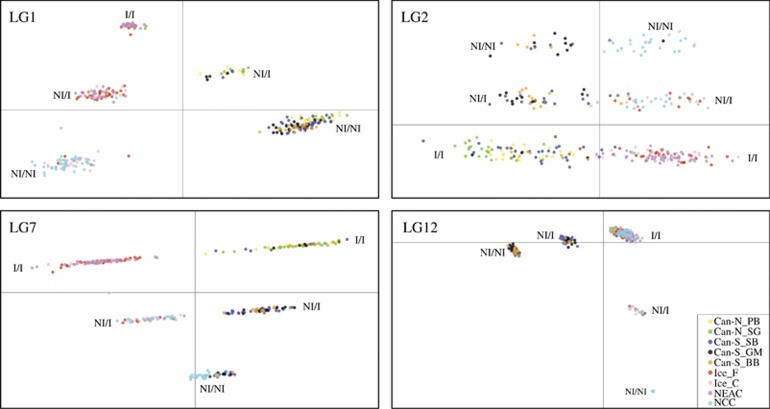
Discriminant analysis of principal components (DAPC) of the SNPs embedded within the inversions in LGs 1, 2, 7 and 12. Within all LGs a clear trimodal pattern, reflecting the inversion ‘genotypes’, is observed in addition to a broad trans-Atlantic division. Each dot represents an individual; NI/NI and I/I denote the homozygote noninverted and inverted clusters, respectively, whereas the NI/I denotes the heterozygote clusters. Inversion frequencies are listed in Supplementary Table S5. The analyses are based on n.pca=2 and n.da=2, calculated in ADEGENET. Can-N_PB, Placentia Bay; Can-N_SG, Southern Gulf of St Lawrence; Can-S_SB, Sambro; Can-S_GM, Gulf of Maine; Can-S_BB, Browns Bank; Ice_F, Iceland Frontal; Ice_C, Iceland Coastal; NEAC, Northeast Arctic cod; NCC, Norwegian coastal cod.